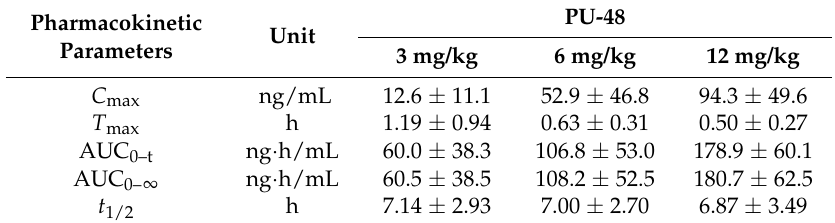
Figure 2. The plasma concentration–time curve within 48 h (( A ), the main graph) and 6 h (( B ), the inset) by semi ‐ log data plot (the y ‐ coordinate was logarithmic coordinates) of methyl 3 ‐ amino ‐ 6 ‐ methoxythieno [2,3 ‐ b] quinolone ‐ 2 ‐ carboxylate (PU ‐ 48) after a single oral administration of PU ‐ 48 self ‐ nanomicroemulsifying drug delivery system (SNEDDS) at three doses (3, 6, 12 mg/kg) in rats detected by the liquid chromatography ‐ tandem mass spectrometry (LC ‐ MS/MS) method ( n = 6, mean ± SD). Table 1. Pharmacokinetic parameters of methyl 3 ‐ amino ‐ 6 ‐ methoxythieno [2,3 ‐ b] quinolone ‐ 2 ‐ carboxylate (PU ‐ 48) after single oral administration of PU ‐ 48 SNEDDS at the doses of 3, 6 and 12 mg/kg in rats plasma (mean ± SD, n = 6).